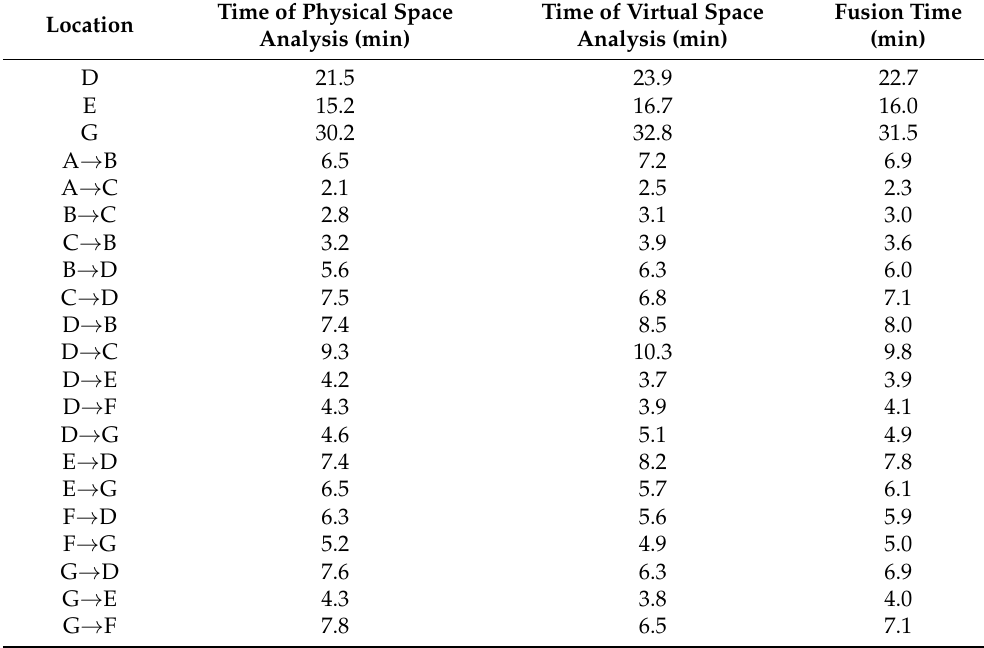
Figure 8. Field layout of construction process. Table 1. Twin data of buffer time and allocation time of each node. Time of Physical Location